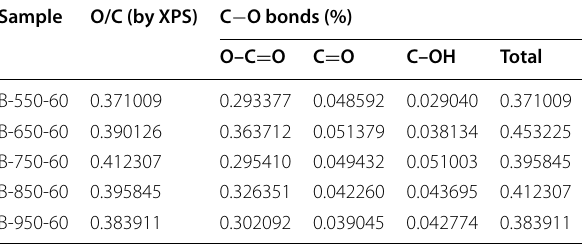
Table 1 Surface O/C ratios by XPS, C–O bond percentages by deconvolution of XPS C 1s specrta